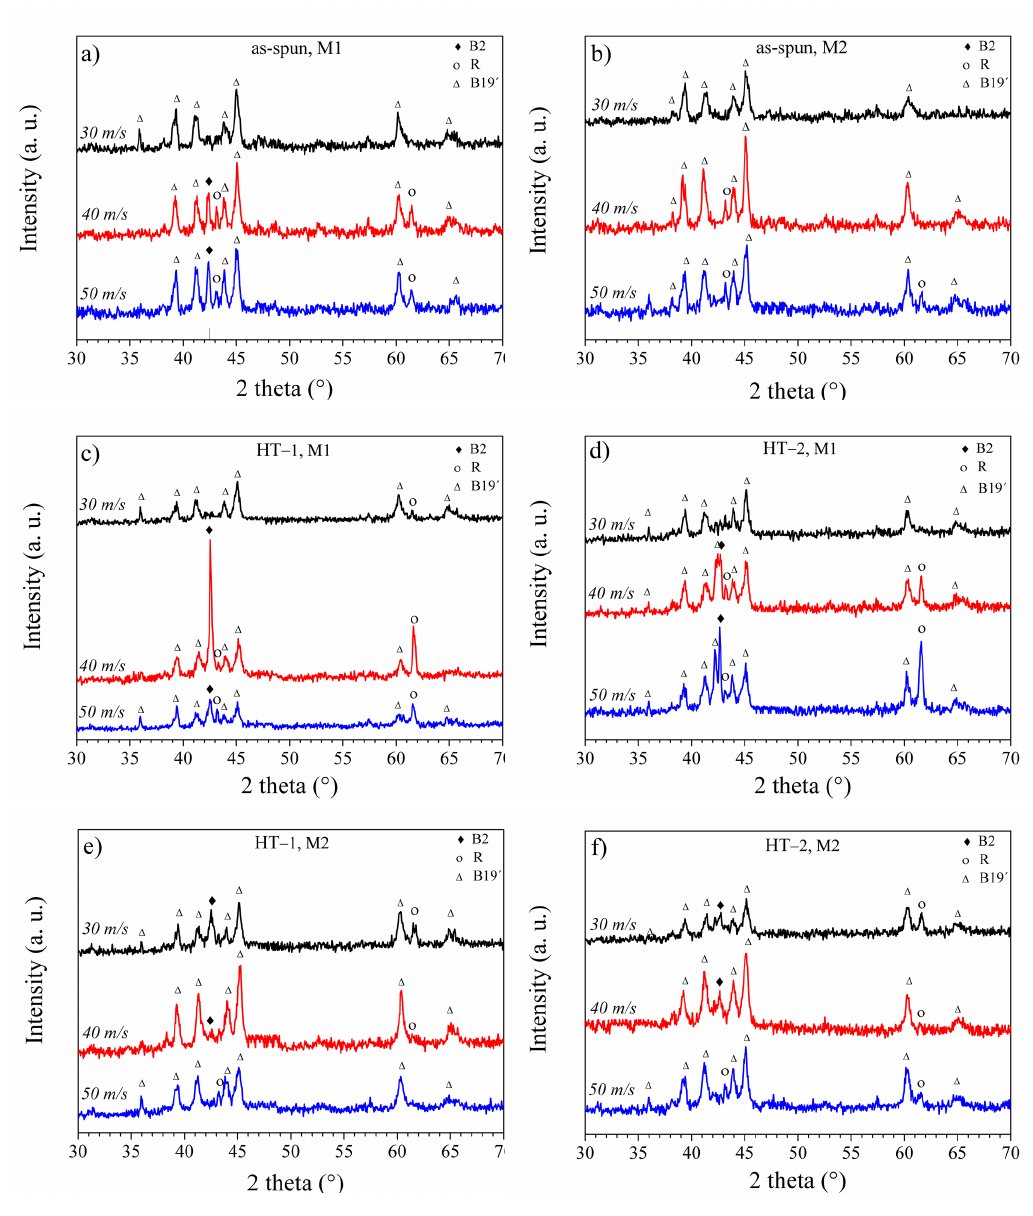
Figure 1. X-ray diffraction analyses of Ti−Ni ribbons of (a-b) as-spun, (c-d) M1 with HT-1 and HT-2, (e-f) M2 with HT-1 and HT-2,